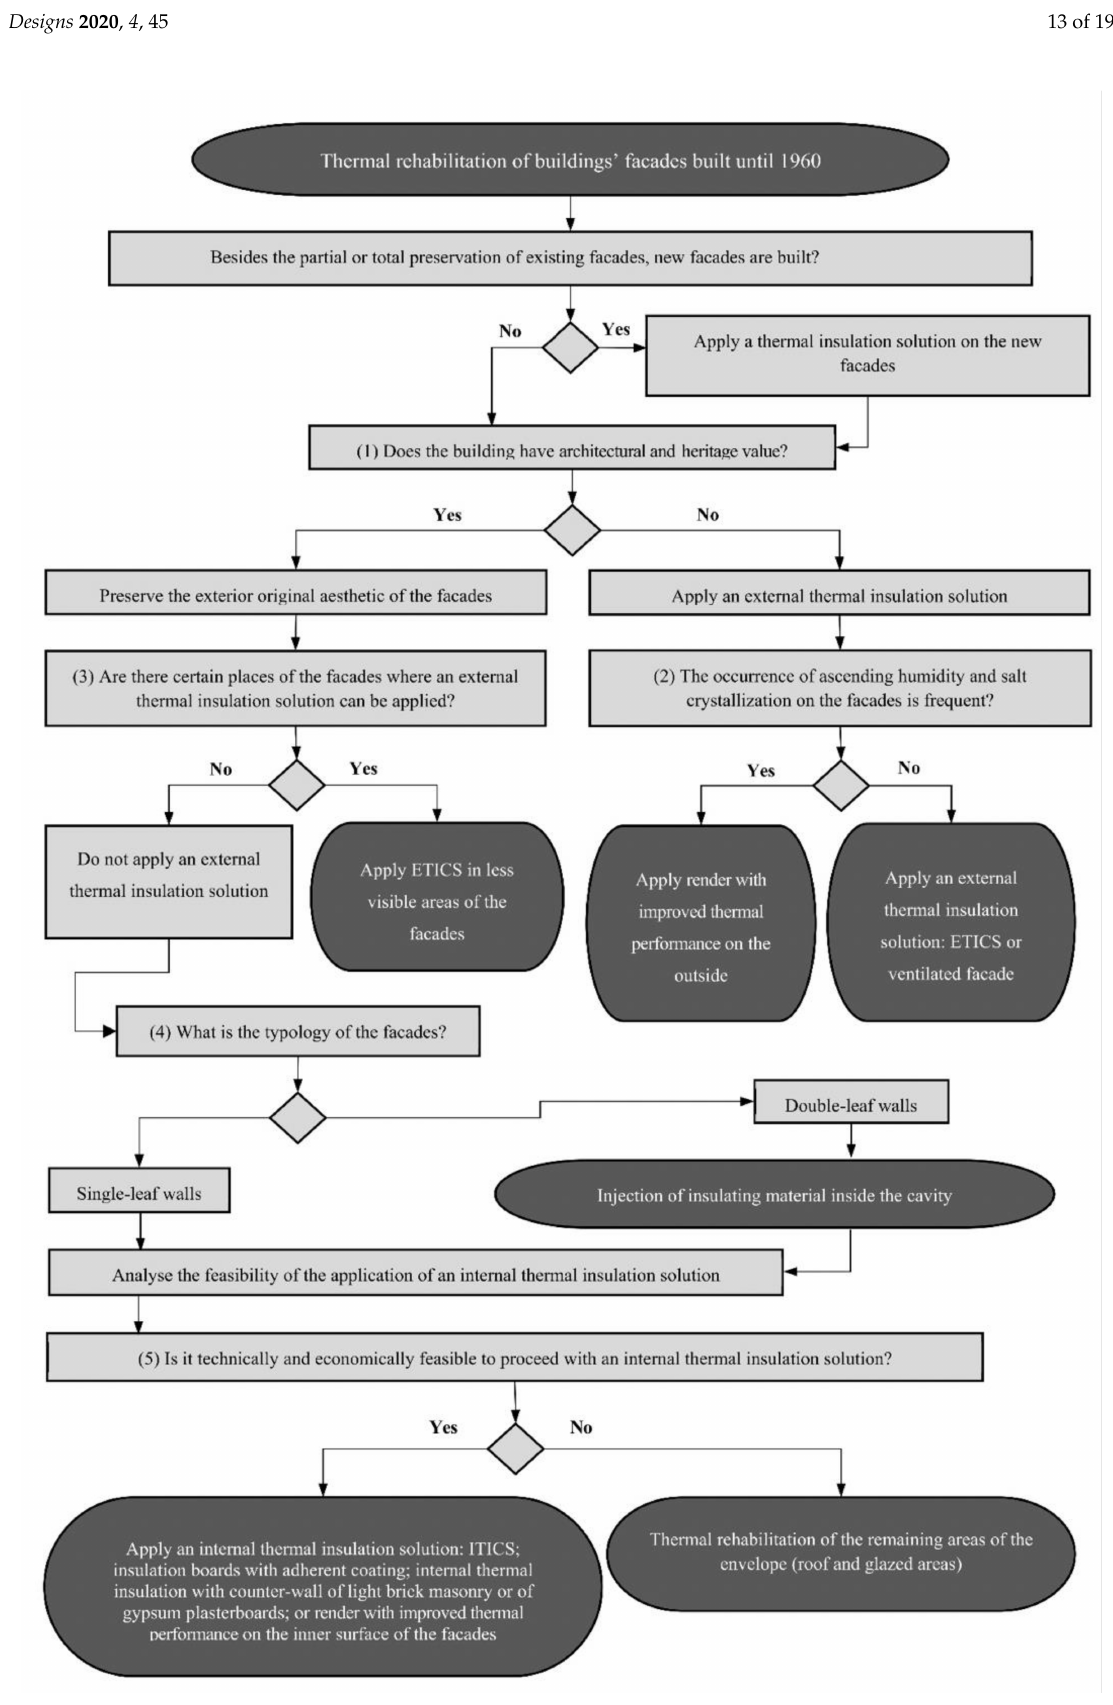
Figure 7. Flowchart to discuss thermal retrofitting strategies of old buildings’